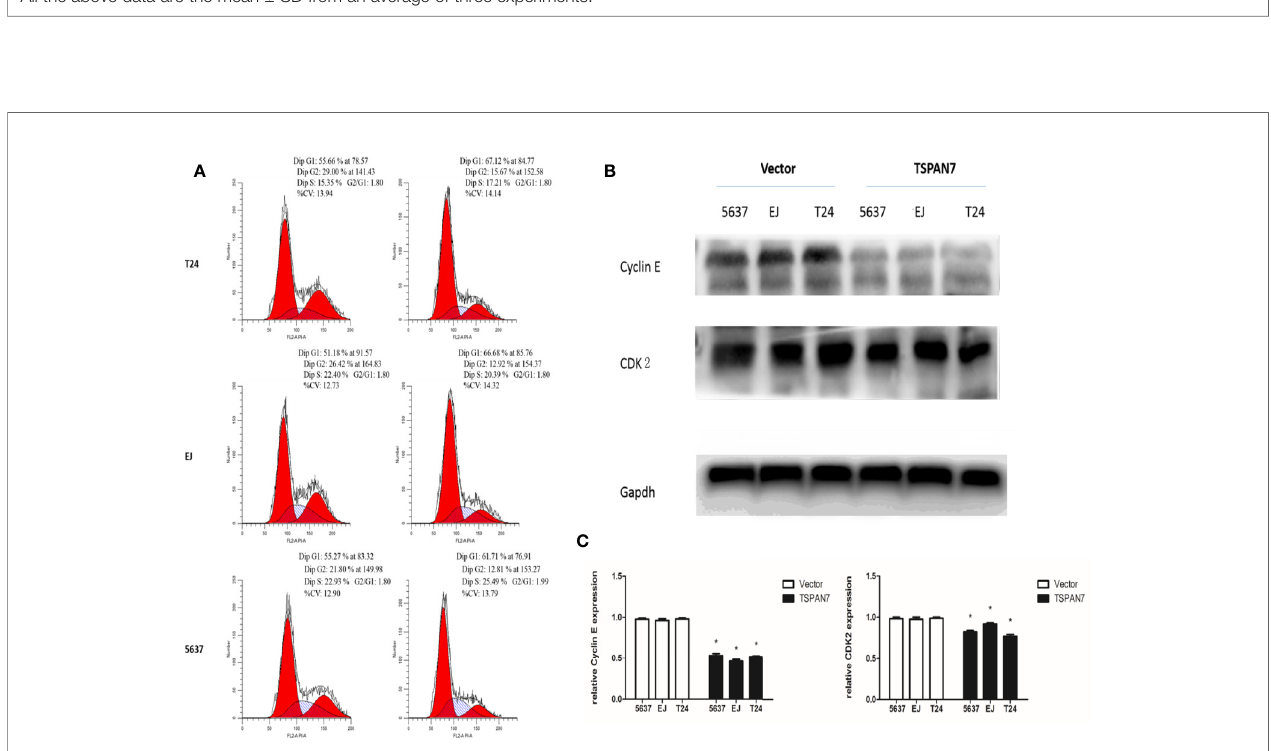
FIGURE 6 | (A) TSPAN7 overexpression induced cell cycle arrest at the G1/S phase. (B) CDK2 and cyclin E expression was downregulated in pcDNA-TSPAN7 groups. (C) Densitometry analysis of western blots showed quantitation of Cyclin E and CDK2 levels.